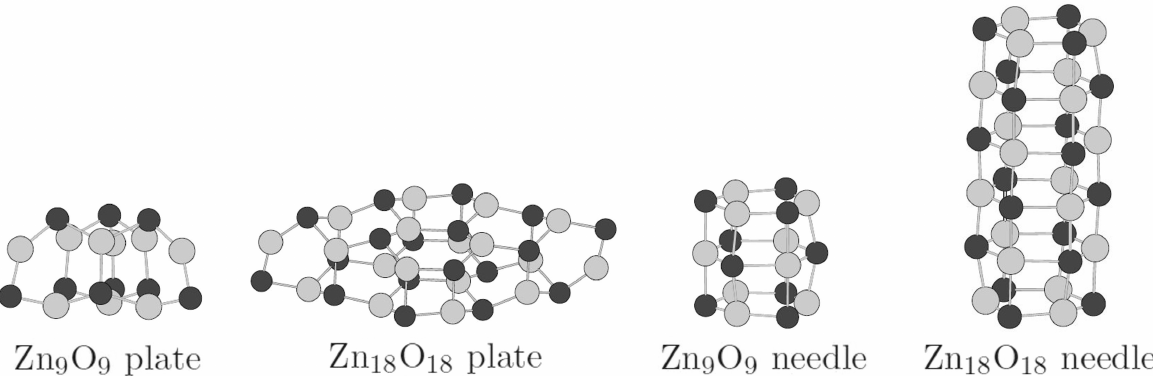
Figure 1. Optimized geometries of needle- and plate-type Zn 18. Zn atoms are shown in gray, while O atoms are depicted in black.